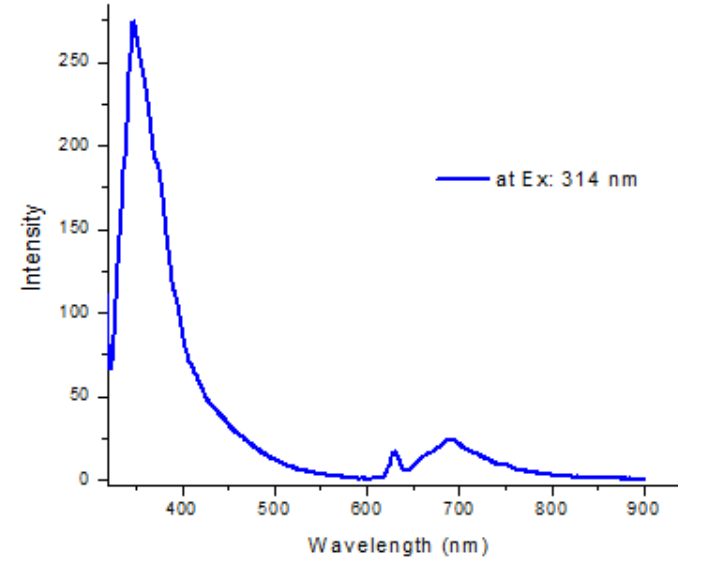
Figure S16: Emission spectrum of dialdehyde m